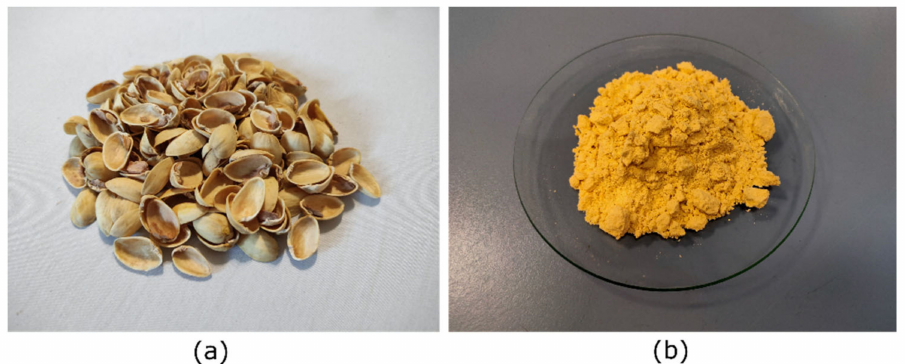
Figure 11. ( a ) Pistachio shells; ( b ) Resultant pistachio shell flour (PSF) after milling and